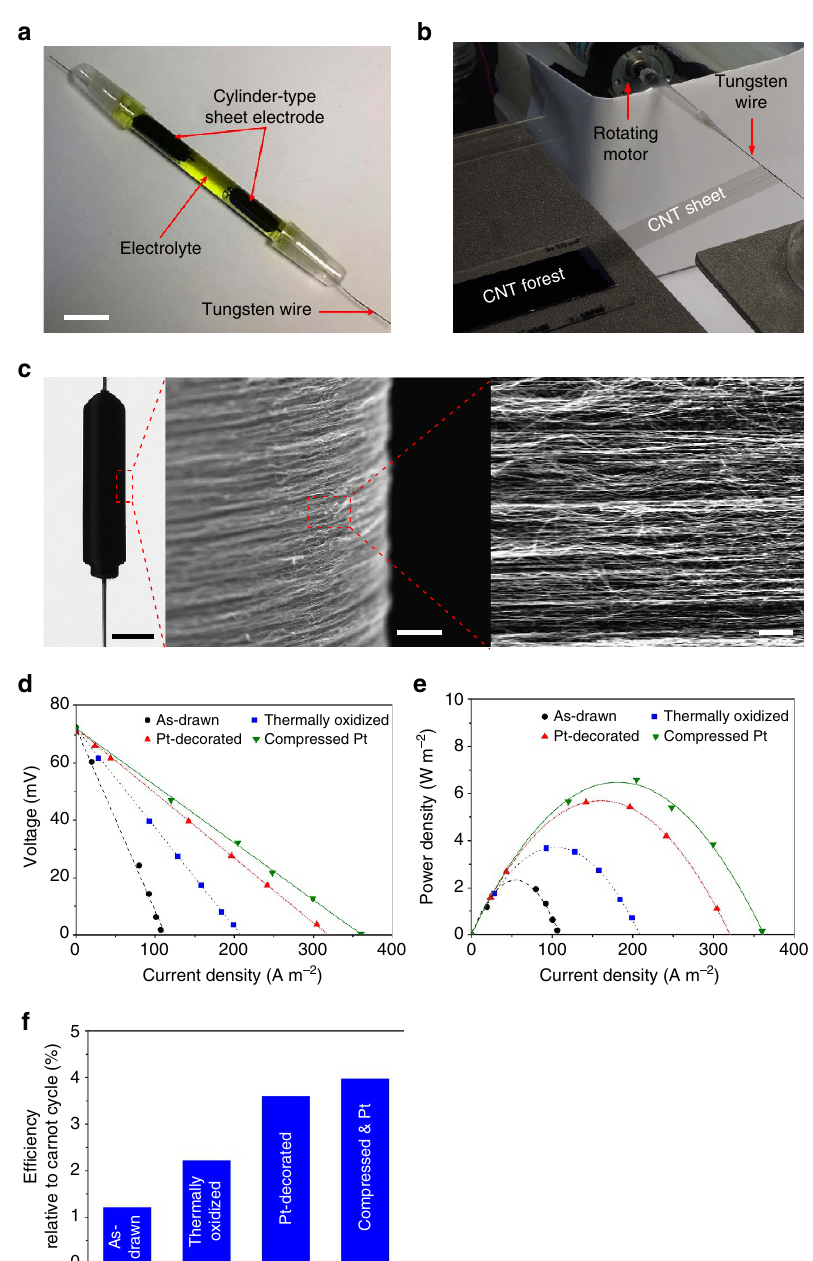
Figure 5 | Fabrication of cylinder-type CNT thermocells and their performance for D T E 51 (cid:2) C. ( a ) Photograph of an assembled thermocell (scale bar, 2cm) and ( b ) apparatus for fabrication of cylindrical CNT thermocell electrodes. ( c ) Photograph and SEM images of a cylindrical CNTelectrode. Scale bars, 3mm (left of panel), 30 m m (middle of panel) and 1 m m (right of panel). ( d ) Cell voltage and ( e ) power density versus current density for variously treated cell electrodes. ( f ) Energy conversion efficiency relative to Carnot cycle efficiency for various CNTelectrodes in the cylindrical cell configuration. All sheet samples (except the as-drawn) were purified by thermal oxidation before assembly into cylindrical